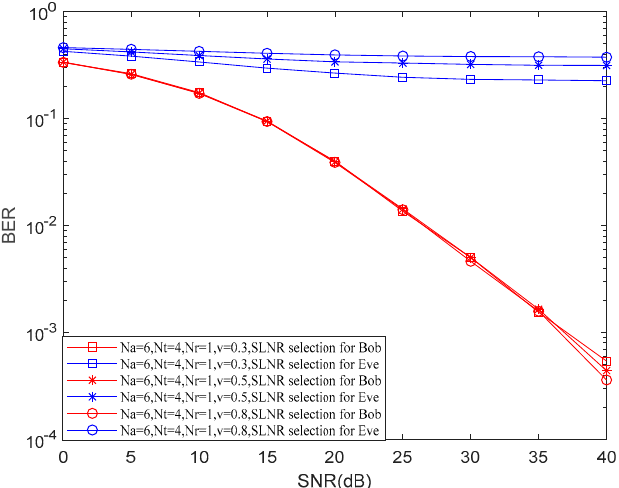
Figure 4. BER over SNR under different schemes for different schemes .